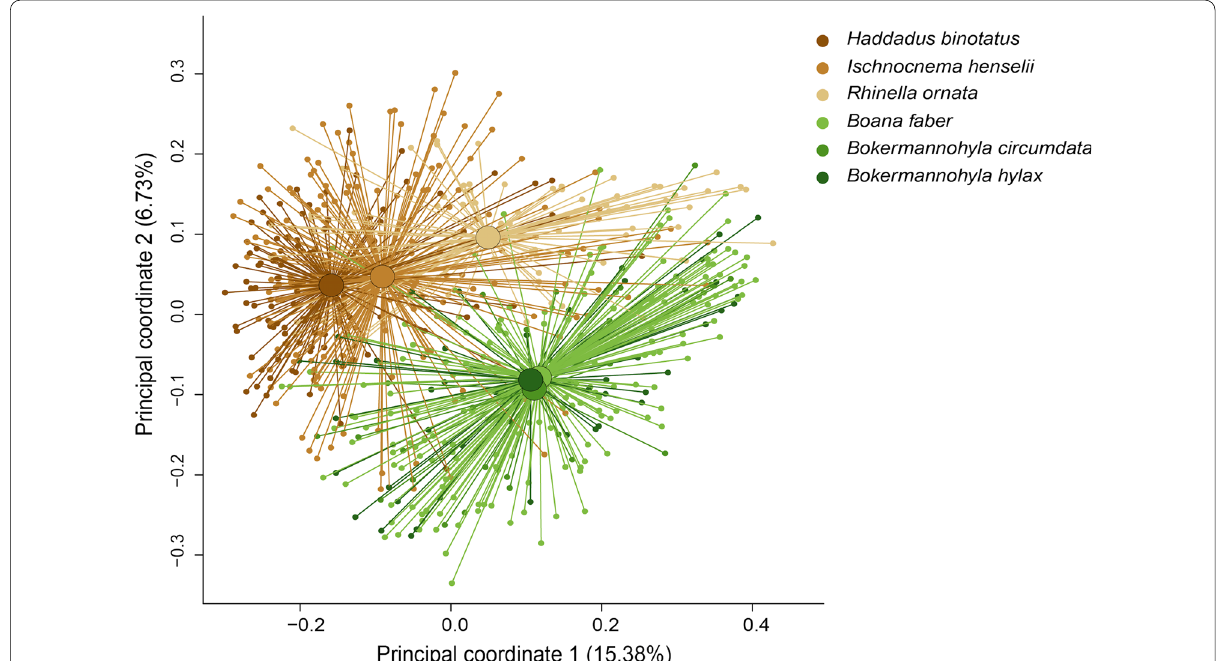
Fig. 3 Community composition of host skin bacteria calculated using principal coordinates analysis based on unweighted UniFrac distances. Small circles indicate data points. Large circles indicate group centroids. Lines indicate distance to group